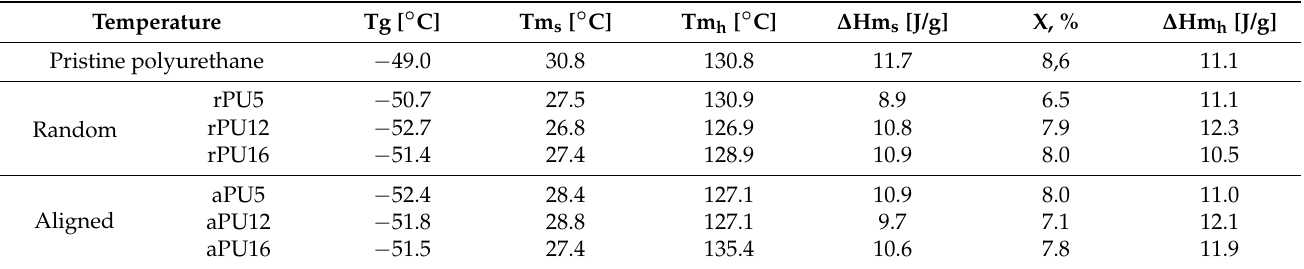
Figure 5. DSC 2nd heating curves for PU mats. Table 3. Summary of the characteristic temperatures DSC results of tested